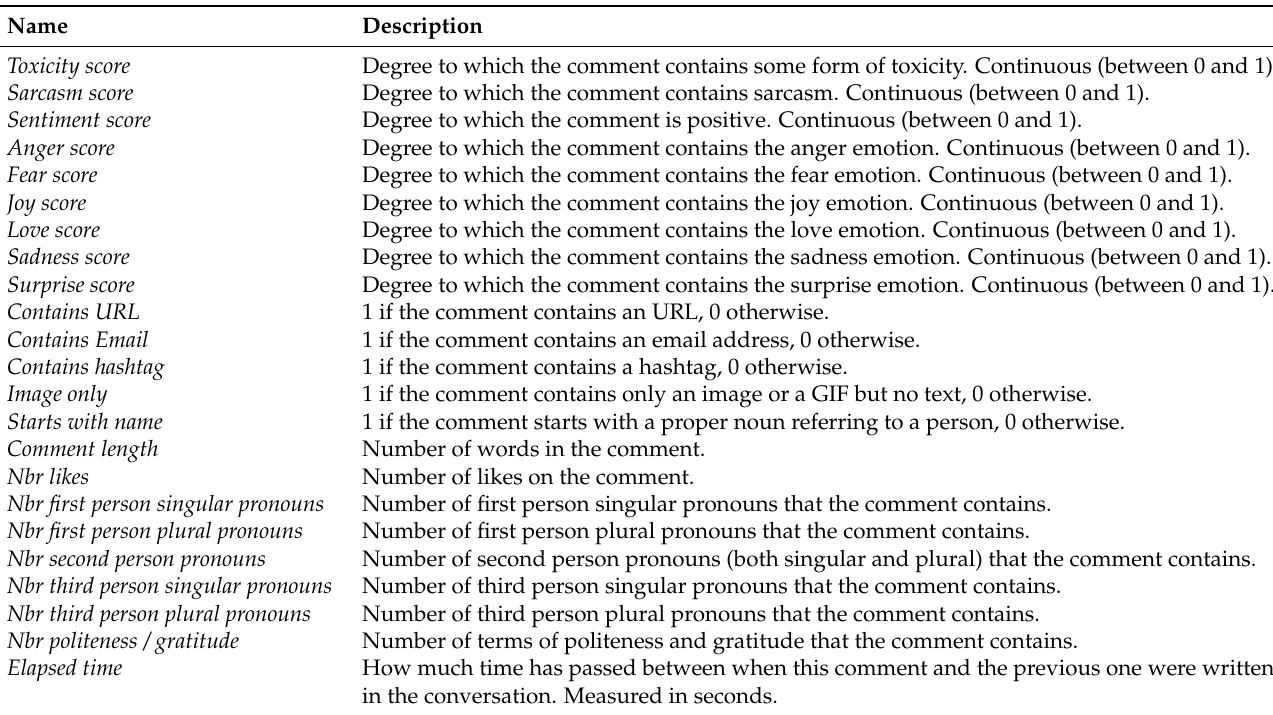
Table 1. Full list of the features extracted from the